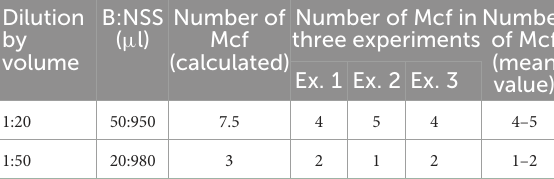
TABLE 1 The number of microfilaria calculated from a blood sample containing 150 Mcf/mL.